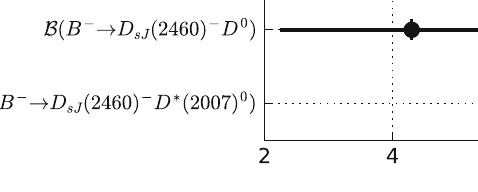
Fig. 125 Summary of the averages from Table 156